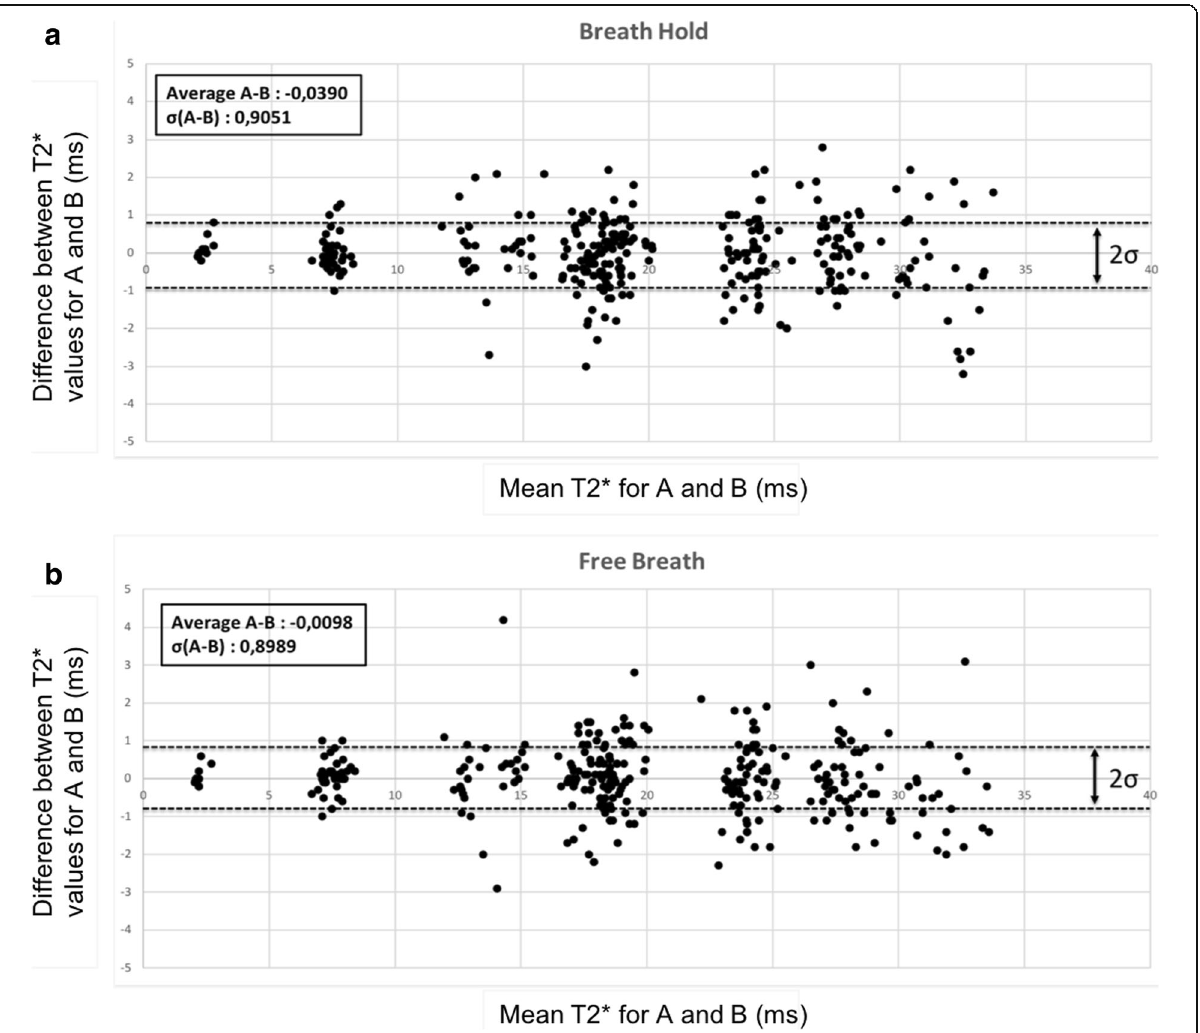
Fig. 4 Bland – Altman plots showing the good agreement for T2* values in the interventricular septum between the first reader ( a ) and the second reader ( b